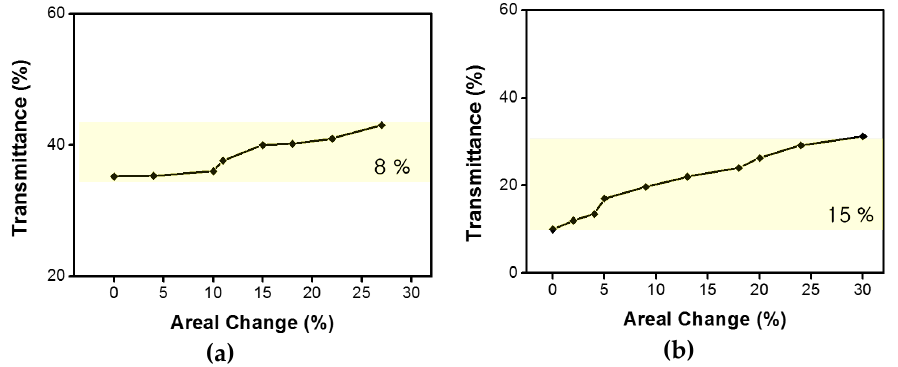
Figure 6. Optical transmittance control of ( a ) a wrinkle-free and ( b ) wrinkled elastomer actuator with electrical input.